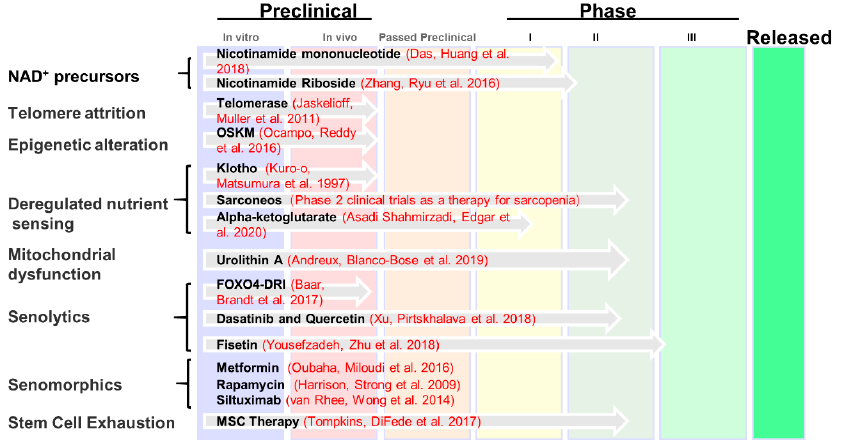
Figure 4. Research and development of clinical anti-aging medication. The information presented in the figure is summarized at https://www.lifespan.io/road-maps/the-rejuvenation-roadmap/, accessed on 20 December 2022. A number of aging-related drugs are currently subject to preliminary exploratory investigations, while other disease-related or anti-cancer drugs have been gradually introduced into anti-aging research. At present, the most promising treatments include drugs targeting NAD + , telomere attrition, epigenetic alteration, deregulated nutrient sensing, mitochondrial dysfunction, senolytics, senomorphics, and stem cell exhaustion